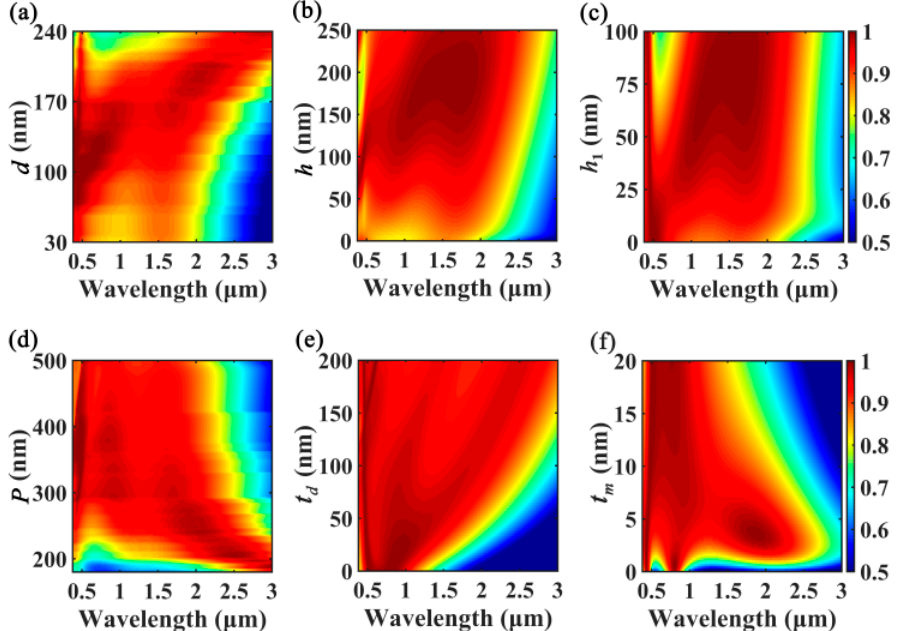
Figure 4. Absorption 2D map of the Cr-based MA as functions of ( a ) diameter of the Cr nanorods d , ( b ) height of the Cr nanorods h , ( c ) thickness of the buffer layer h 1 , ( d ) period P , ( e ) thickness of SiO 2 film t d , and ( f ) thickness of Cr film t m . Other parameters are kept the same as Figure 1a.